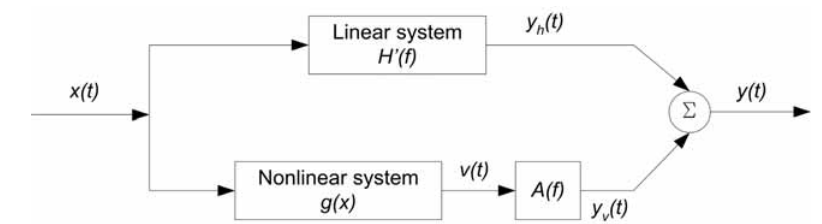
Fig. 5. MISO model used to determine the nonlinear